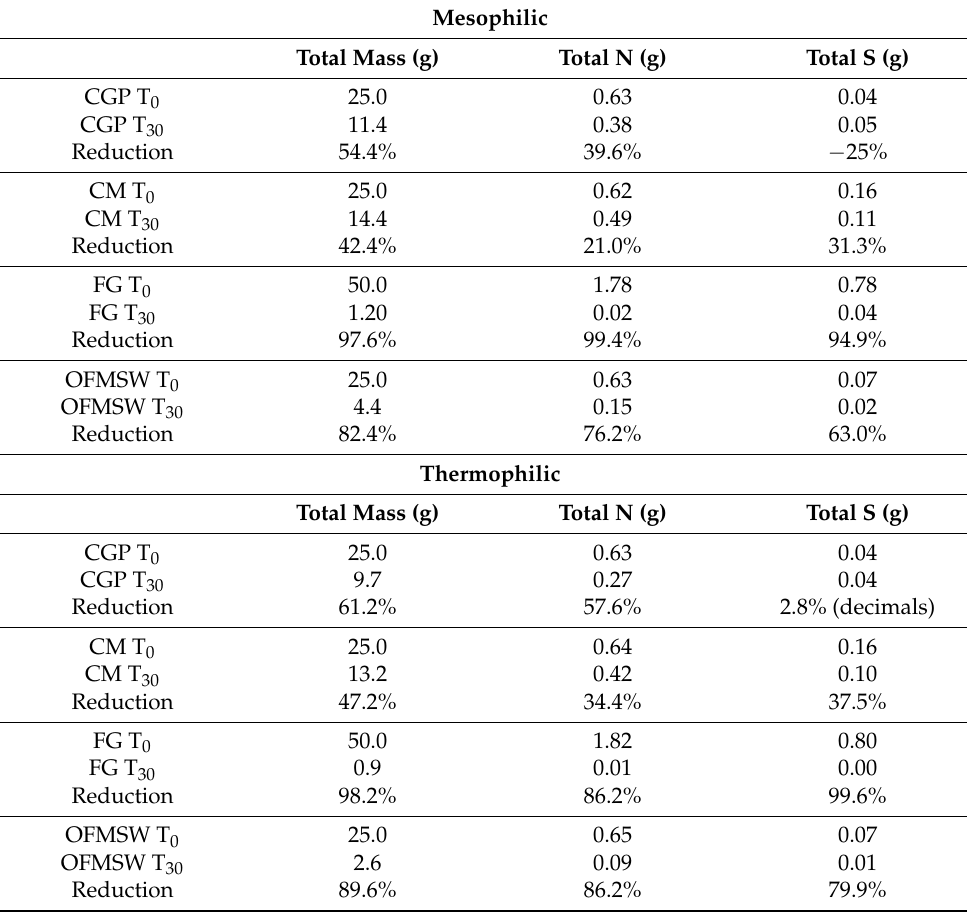
Table 5. Overview of total average mass reduction, N and S mineralization in semi-continuous